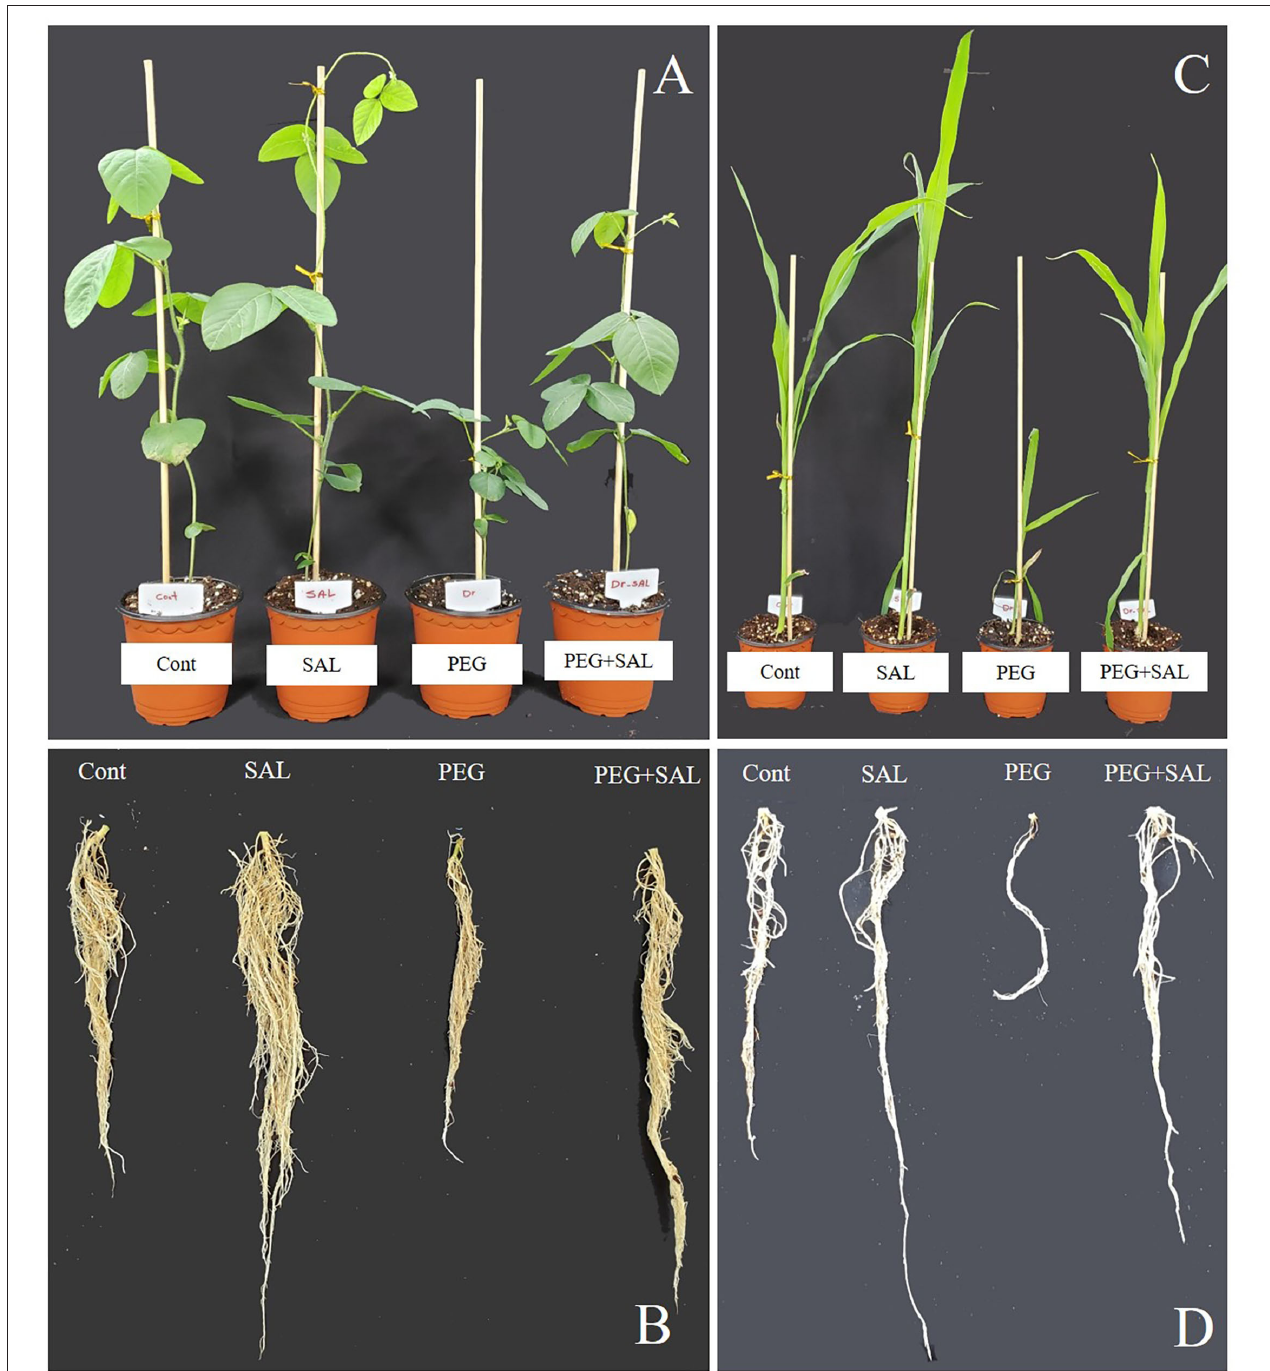
FIGURE 1 | Impact of salvianolic acid on soybean and maize plant growth and root under normal and stress conditions 8 days post-treatment (A–D) . Treatments: Cont (control), SAL (0.1 µ M salvianolic acid), SAL (1 µ M salvianolic acid), PEG (25% polyethylene glycol), SAL (0.1 µ M salvianolic acid) + PEG (25% polyethylene glycol), and SAL (1 µ M salvianolic acid) + PEG (25% polyethylene glycol). Values show the means ± SE ( n = 6) and significant differences at p < 0.05 (Tukey